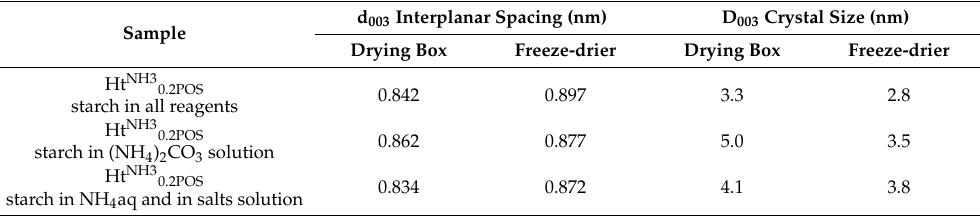
Figure 3. Impact of the method of starch addition (to all reagents, only to (NH 4 ) 2 CO 3 , or to NH 3 aq + salt solutions) and of the method of drying (drying box—DB or freeze-drier—FD) on XRD patterns of HT NH3 0.2POS . Table 2. The e ff ect of the method of starch addition and of the method of drying on XRD determined d003 interplanar spacings, and D 003 crystal